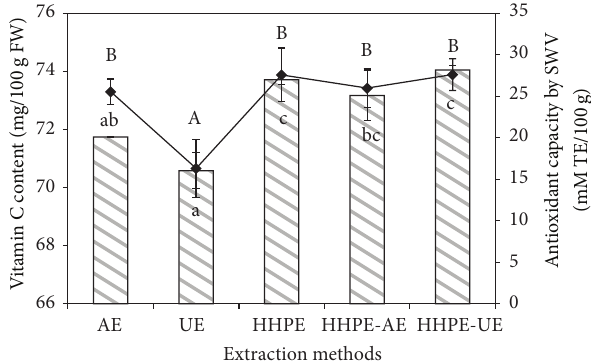
Figure 1: Vitamin C content and capacity antioxidant by SWV of chilean papaya obtained by using different extraction methods. Values are mean ± standard deviation ( 𝑛 = 3 ). Identical letters above the bars indicate no significant difference ( 𝑃 < 0.05